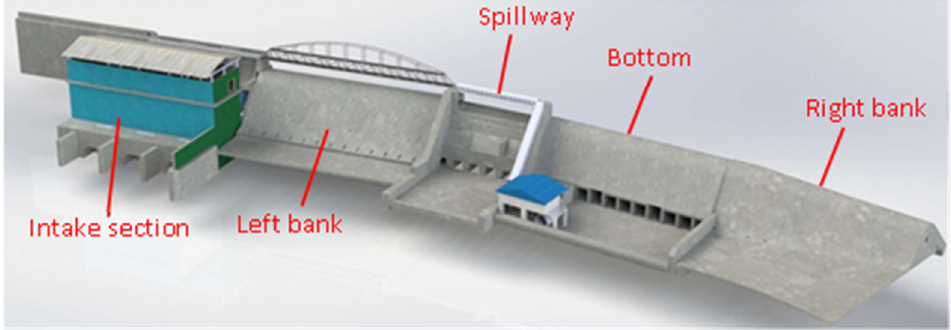
Figure 2. Downstream view of the overall Chenderoh Dam.